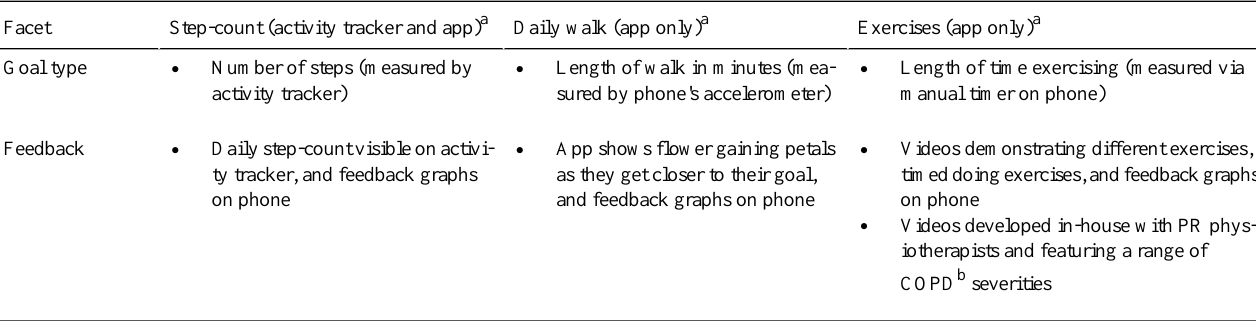
Table 1. Summary of physical activity components within the SMART-COPD